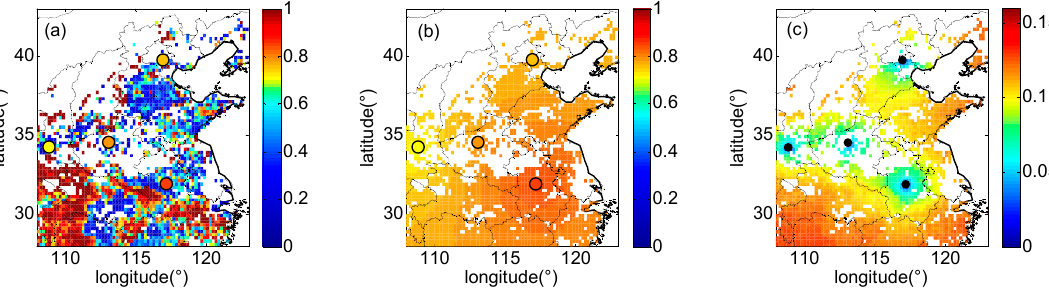
Figure 4. ( a ) Mean FMF observations from MODIS; ( b ) FMF fusion result obtained from universal kriging (UK); and ( c ) uncertainty associated from the UK estimates, expressed as a standard deviation. All data are for the period from 22 December to 28 December 2014. The colored solid circles in the figures are the ground-based locations and their values.